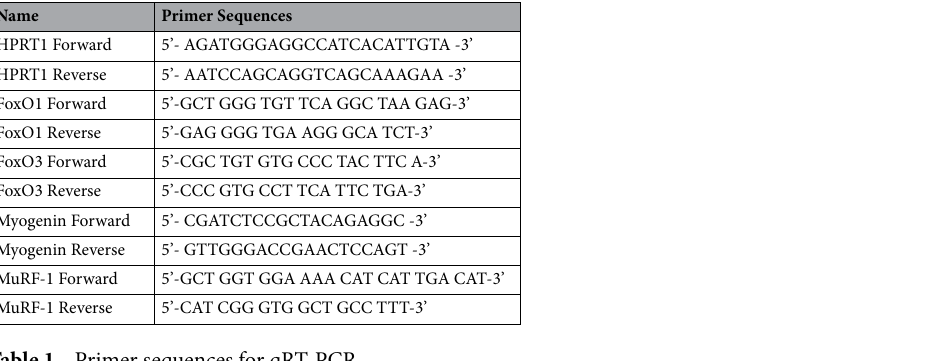
Table 1. Primer sequences for